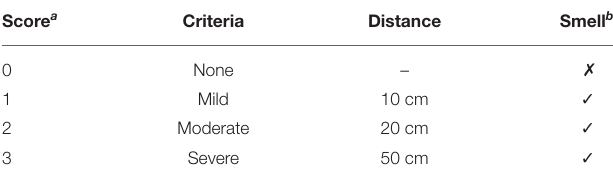
TABLE 1 | Classification criteria of the proposed score method. Score a